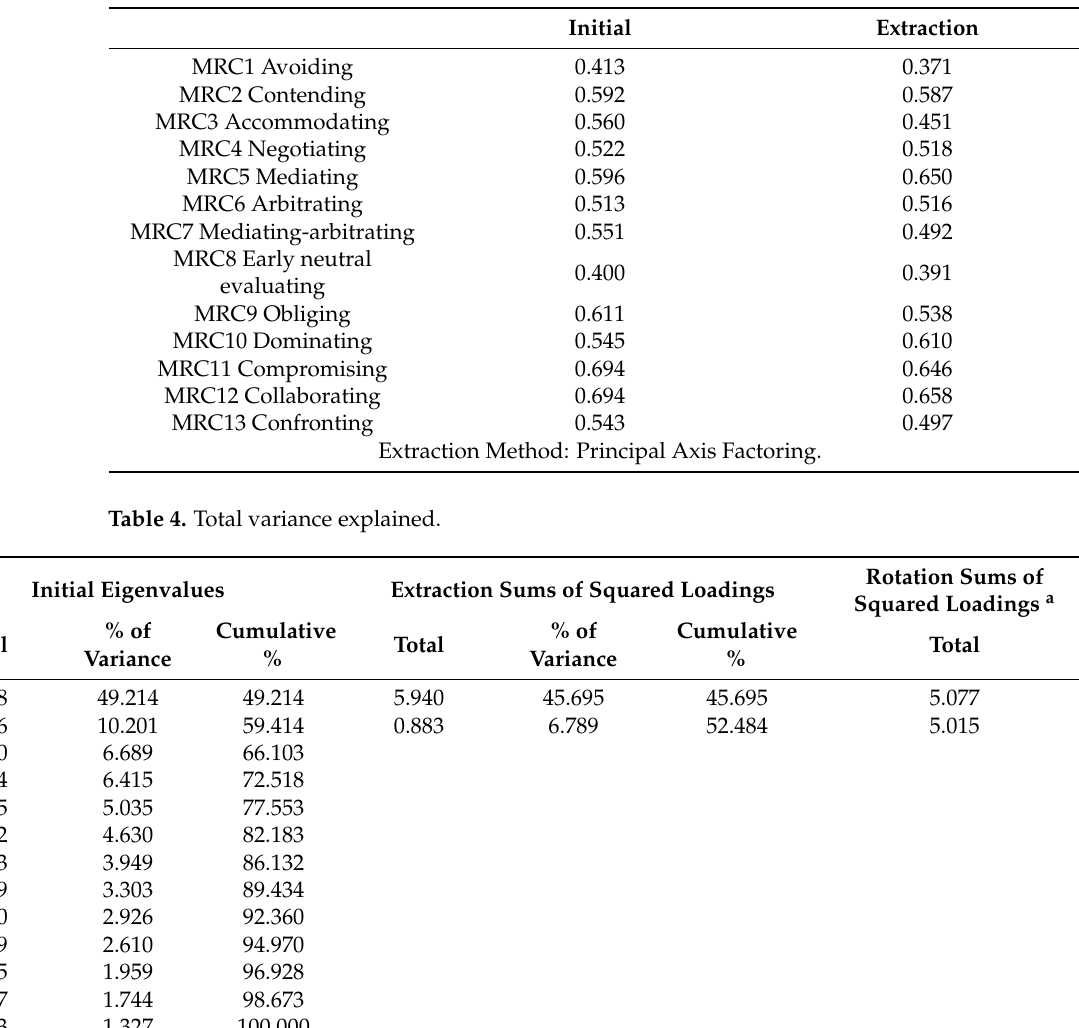
Table 3. Communalities.